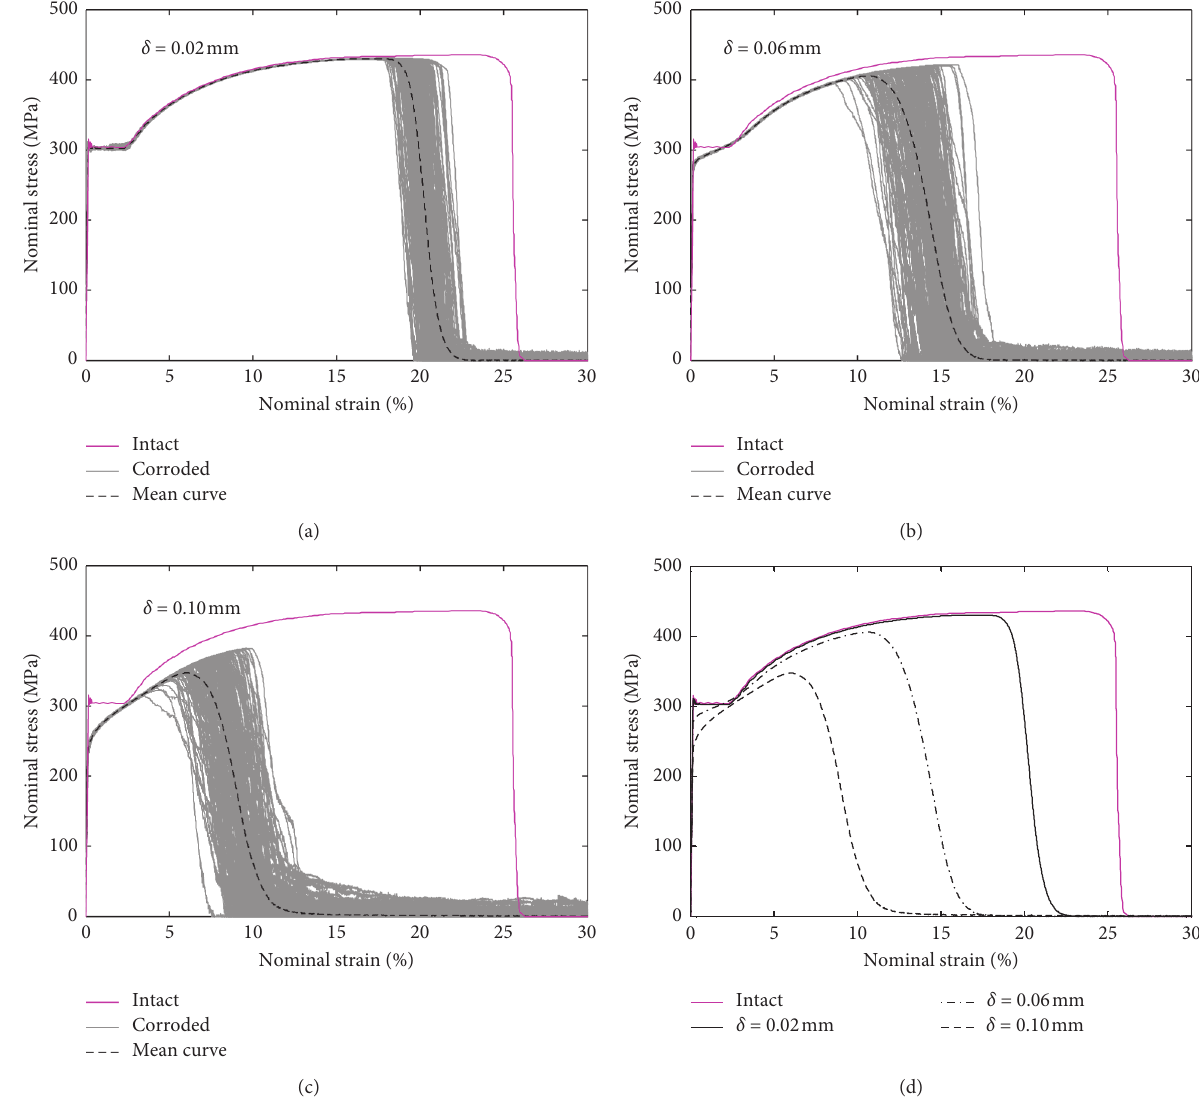
Figure 16: Stress-strain curves predicted using MCS with 300 samples ( η �